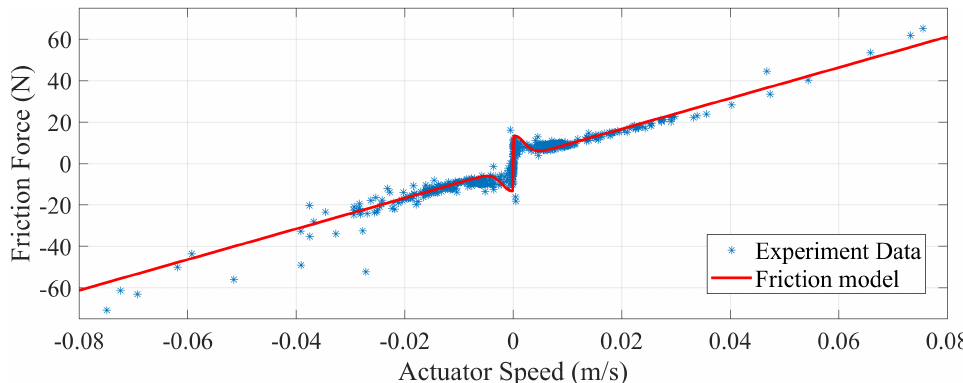
Figure 7. Stribeck effect model found by experimental data. Table 1. Parameters of C-EHA used in this